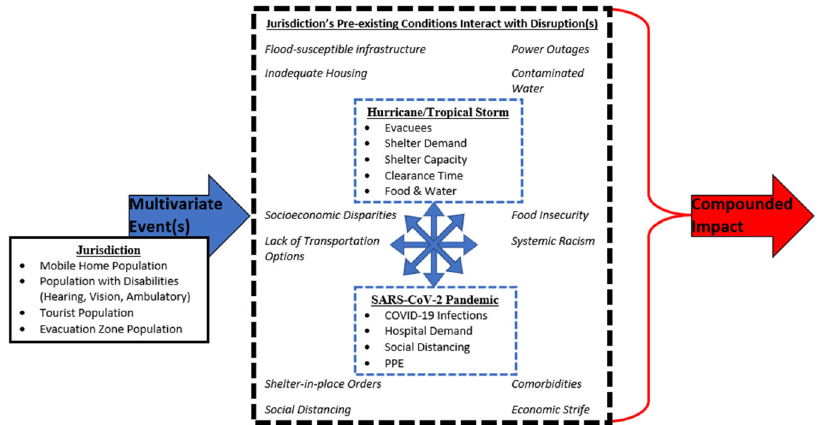
Fig. 1 Overview of the compounding threats arising from the con fl uence of the SARS-CoV-2 pandemic and the 2020 hurricane season. Notional community ’ s vulnerable population for hurricane evacuation (solid black line) experiencing compounding threats from acute disruptions (blue dashed line) and pre-existing disruptions (dashed black line) leading to compounding impacts through layered and exacerbating connections and system